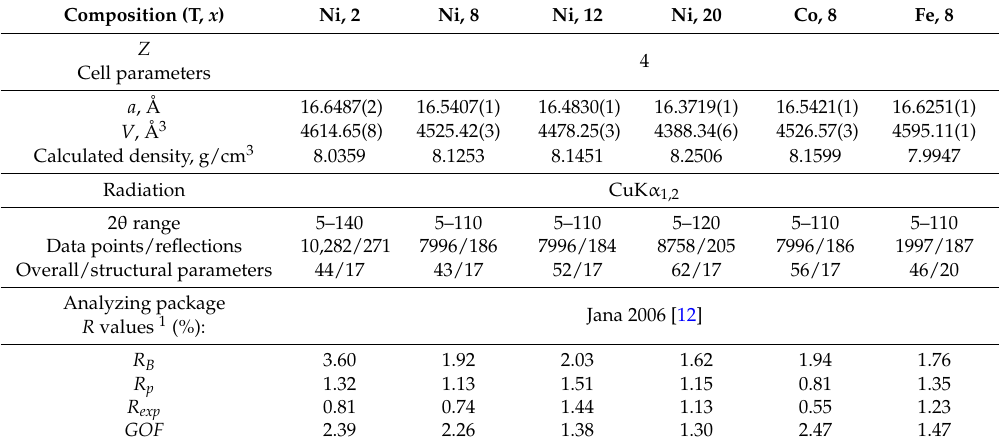
Table 1. Details of the powder XRD experiment for Eu 7 Cu 44- x T x As 23 phases (space group) 2 .